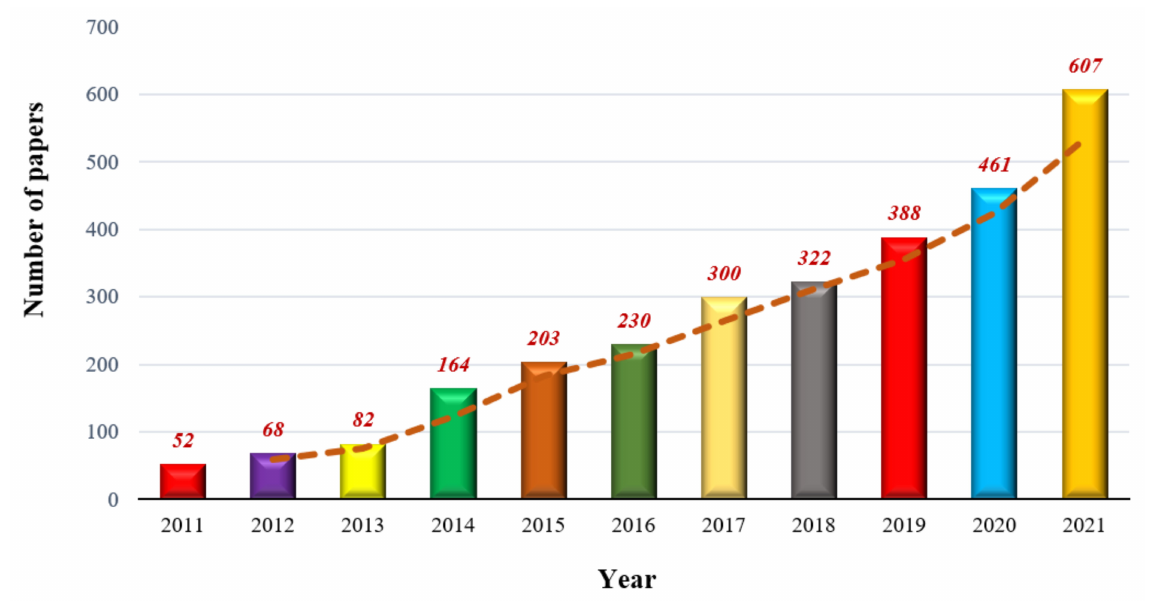
Figure 2. Research trends between the years 2011 and